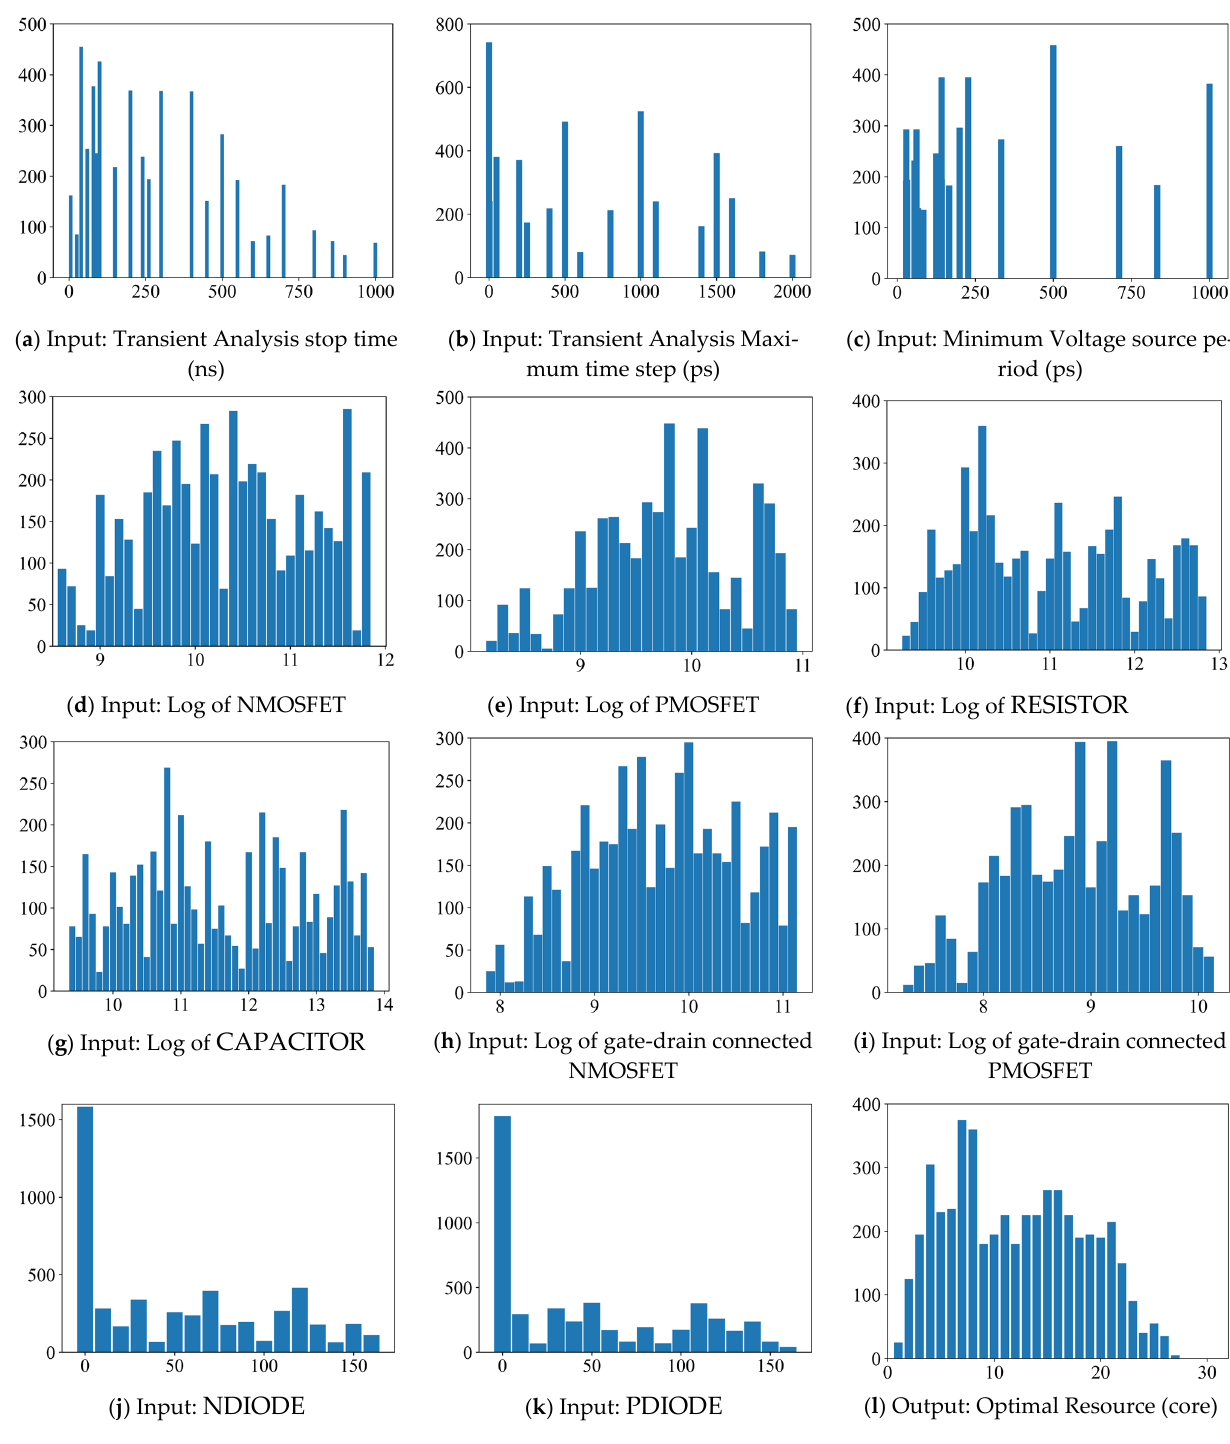
Figure 5. Distribution of collected dataset.